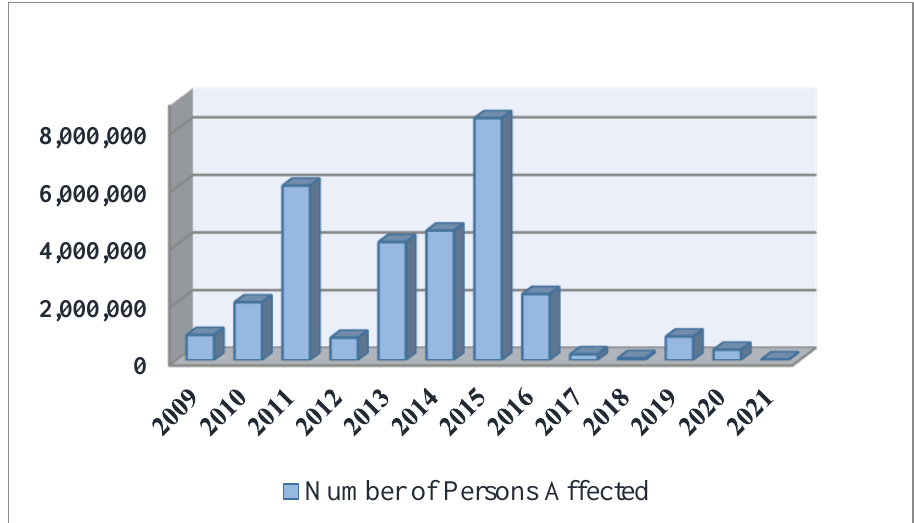
Figure 5. Year-wise number of persons affected due to cyberattacks in HMS [22,39].